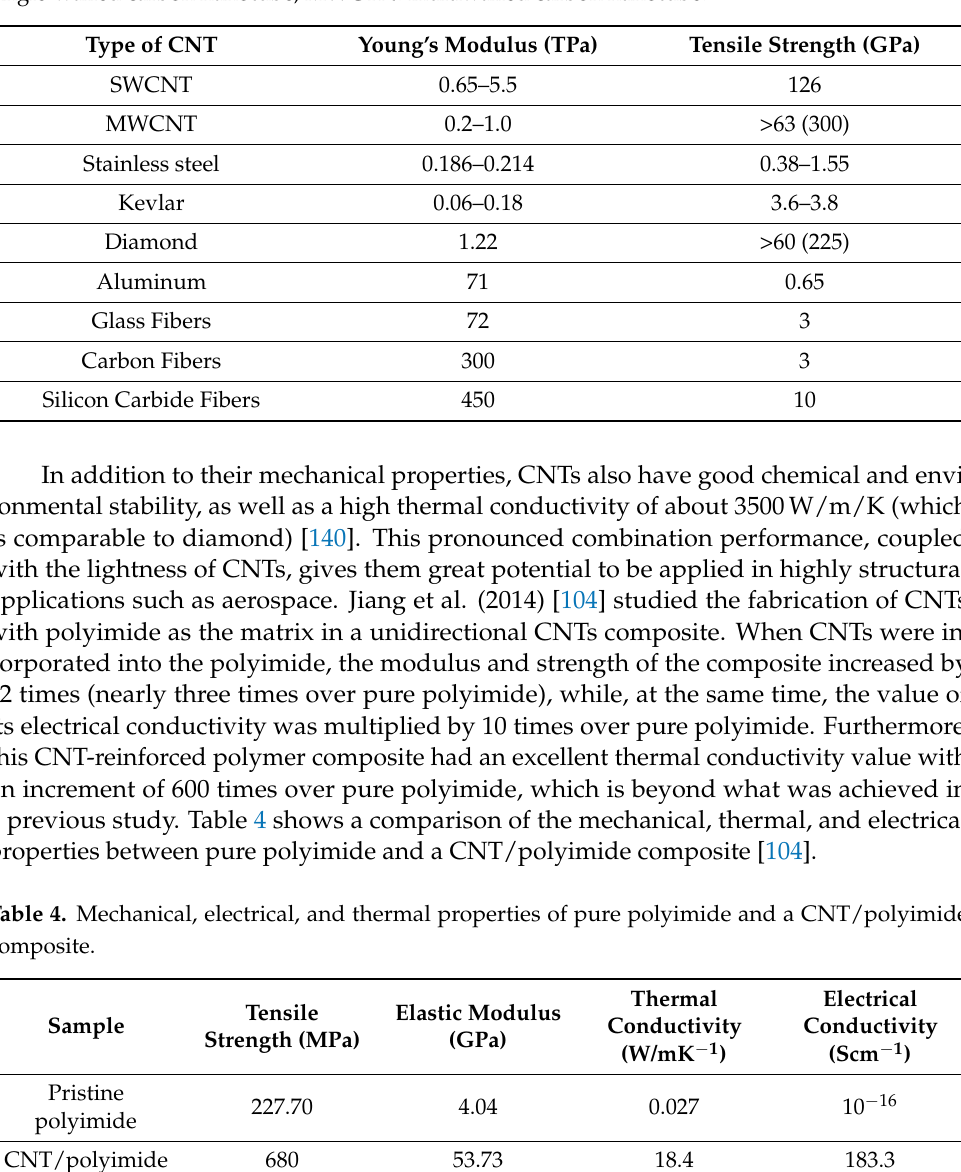
Table 3. Typical mechanical properties of CNT with other common structural materials. SWCNT: single-walled carbon nanotube; MWCTN: multiwalled carbon nanotube.